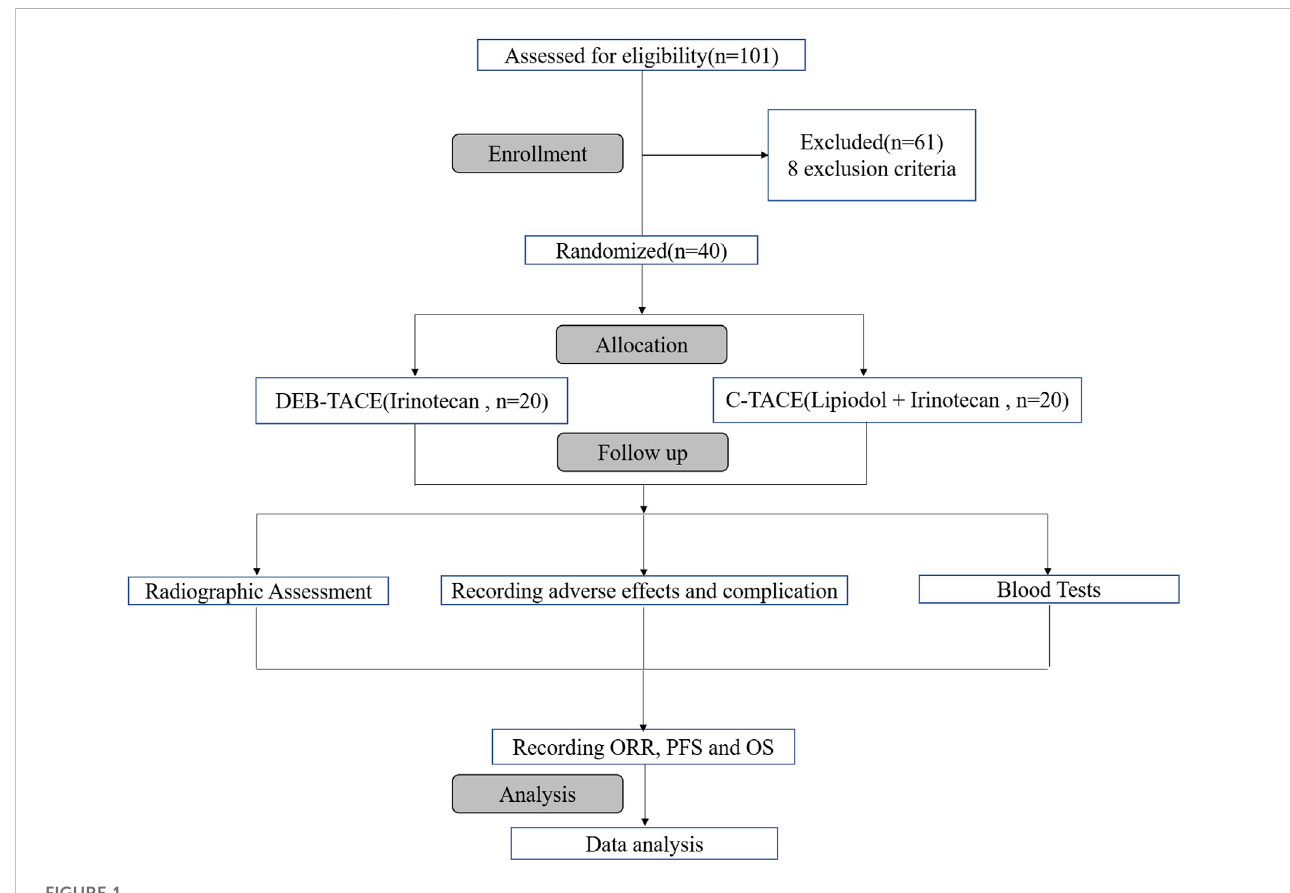
FIGURE 1 Flowchart of the trial pro fi